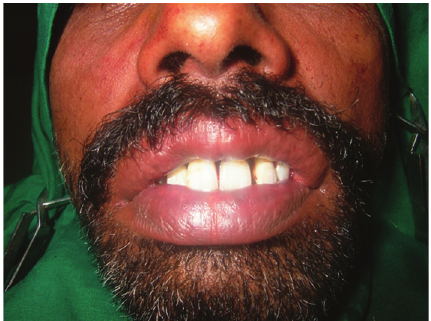
Figure 5: Immediate postoperative view.